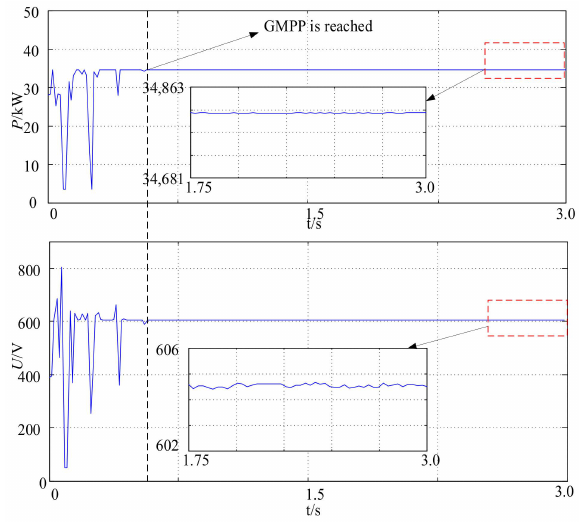
Figure 6. Voltage and power waveforms of IFA for case 1 if global maximum power point (GMPP) occurs at